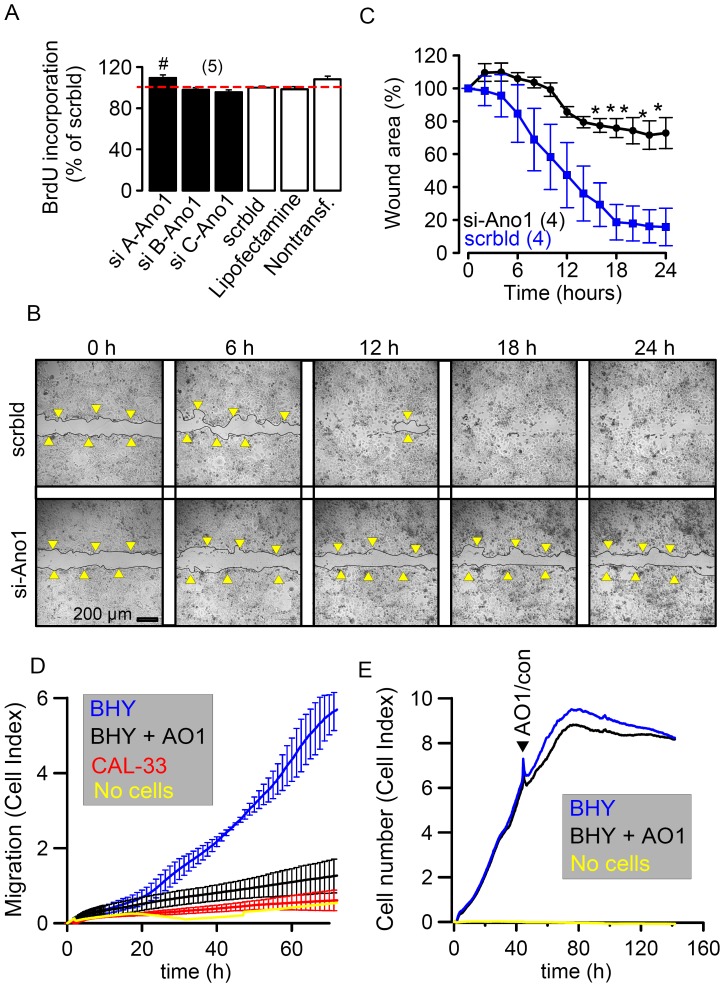

Ano1 causes cell migration.
A) Summary of BrdU incorporation in BHY cells after various treatments, shown as % of BrdU incorporation, when compared to cells treated with scrambled RNA (red dashed line). B) Representative images of wound healing in a scratch assay with BHY cells, treated with scrambled RNA (upper panels) or after Ano1-knockdown with siRNA-Ano1 (lower panels). Yellow arrowheads indicate edges of the damage. C) Time course for the wound healing process (closure of the scratch) for control cells (scrambled RNA) and after Ano1-knockdown (si-Ano1). D) Migration of BHY and CAL-33 cells measured continuously as cell index using the xCELLigence system. Inhibition of migration by blockade of Ano1 with AO1 (10 µM). E) Cell Proliferation measured continuously as cell index using the xCELLigence system. AO1 (10 µM) has no effect on proliferation. Experiments were performed at least in triplicates. Mean ± SEM, (number of experiments). #indicates significant difference (p<0.05, ANOVA).